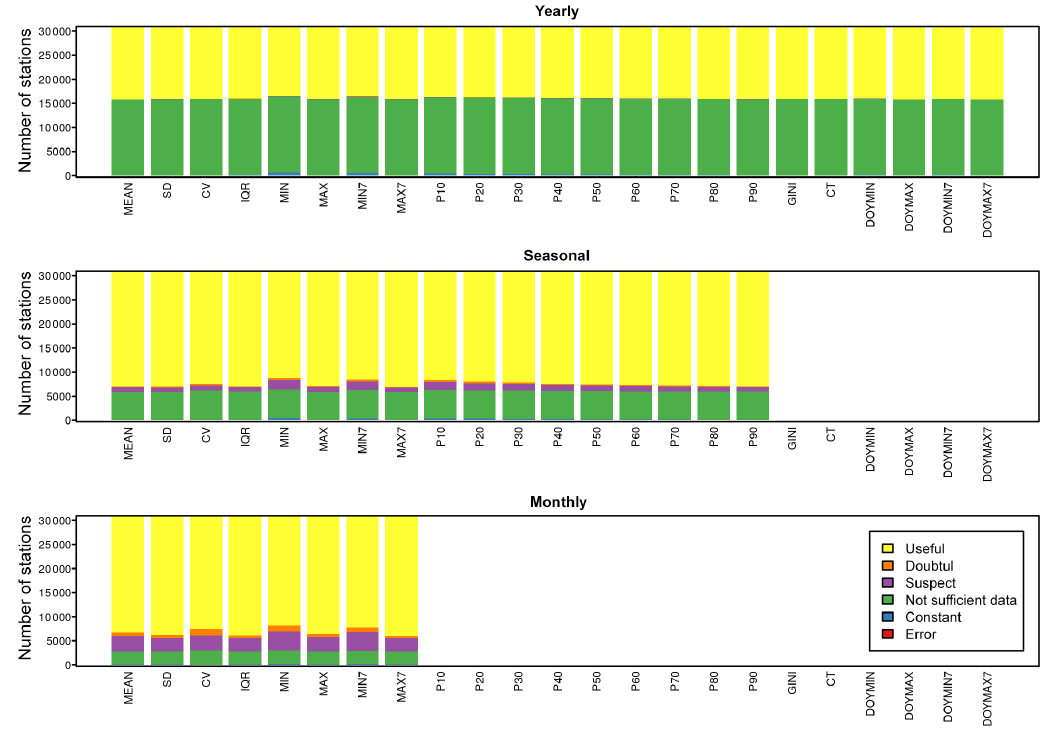
Figure 6. Global summary of the homogeneity analysis for all considered indices at yearly, seasonal and monthly resolution. Shown are the number of stations that are classified as (1) useful, (2) doubtful, (3) suspect, (4) not sufficient data, (5) constant and (6) error according to Sect. 4.1.3. Note that all six categories do occur, although some of them are rare and thus barely visible in the figure.